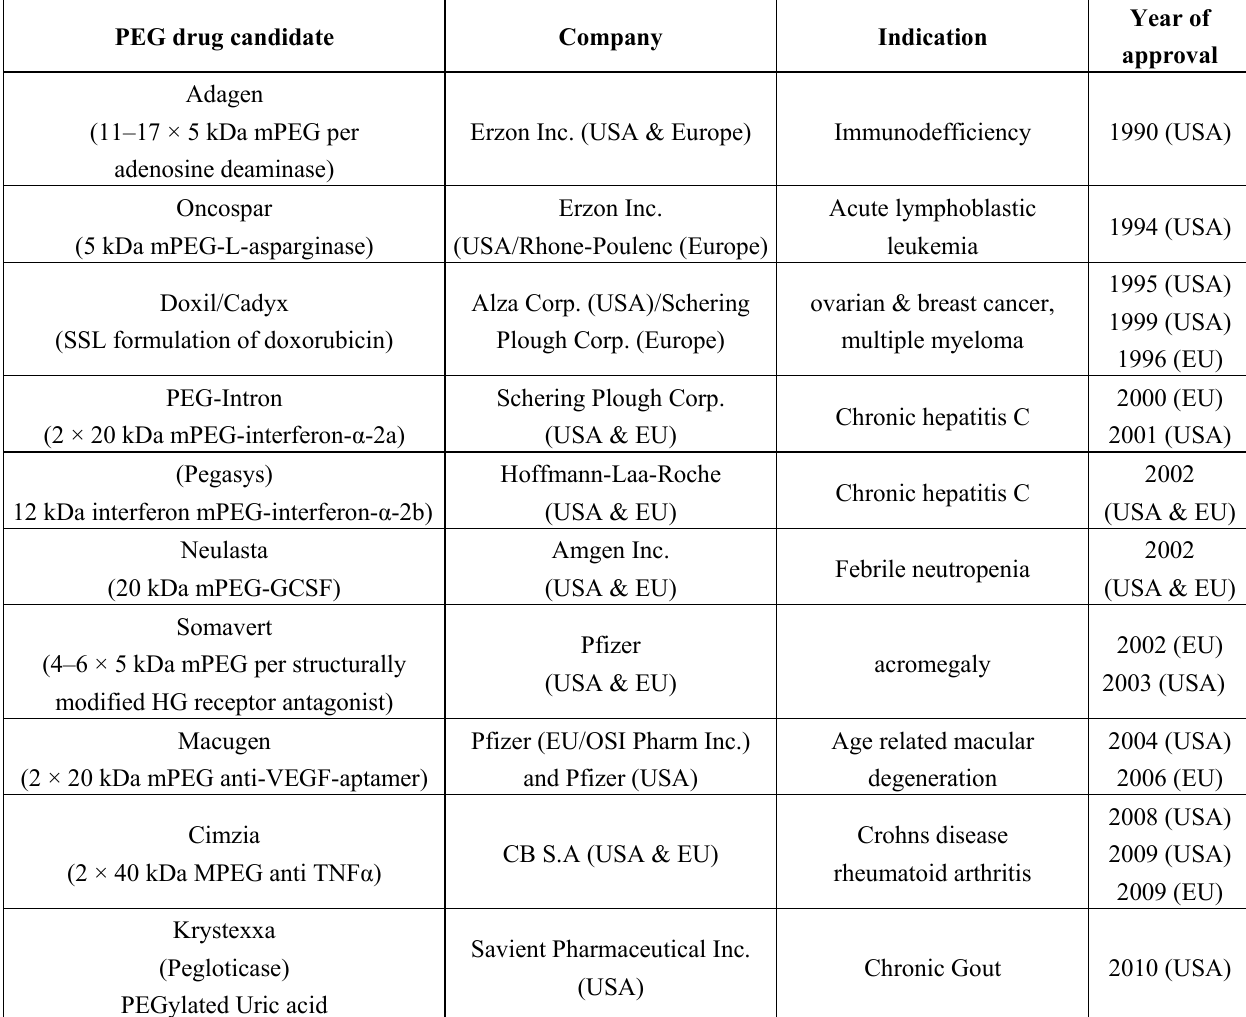
Table 1. Drug delivery systems stabilized with poly(ethylene glycol) PEG that have received regulatory approval in the USA and EU